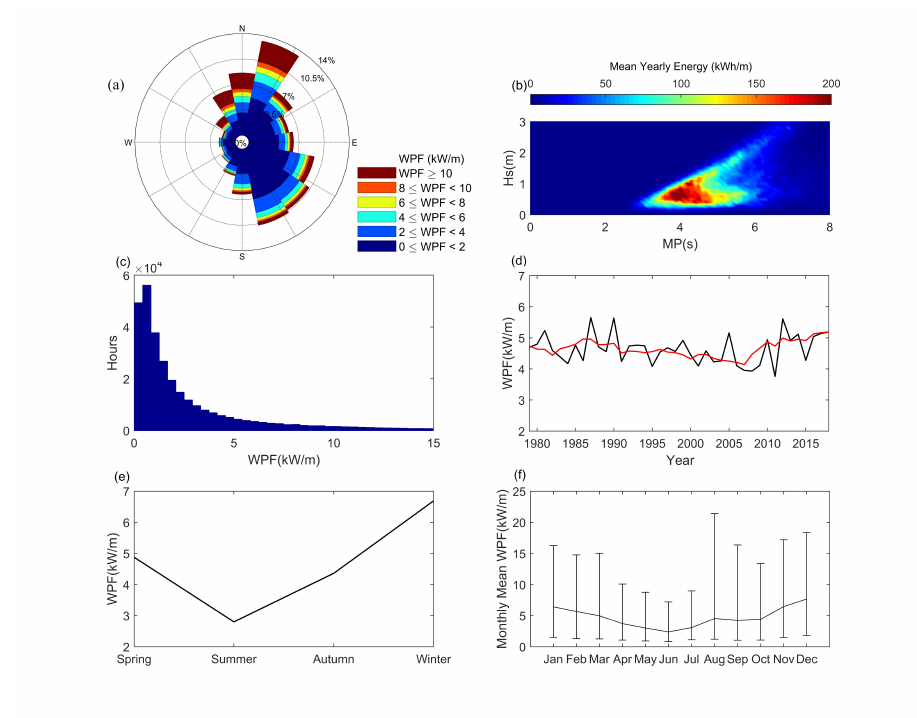
Figure 14. Wave energy assessment for A2 (( a ) The wave power rose; ( b ) the wave power matrix; ( c ) persistence of the wave power in hours; ( d ) black line:yearly mean wave power, red line: 5 year mean wave power; ( e ) seasonal mean wave power; ( f ) monthly mean wave